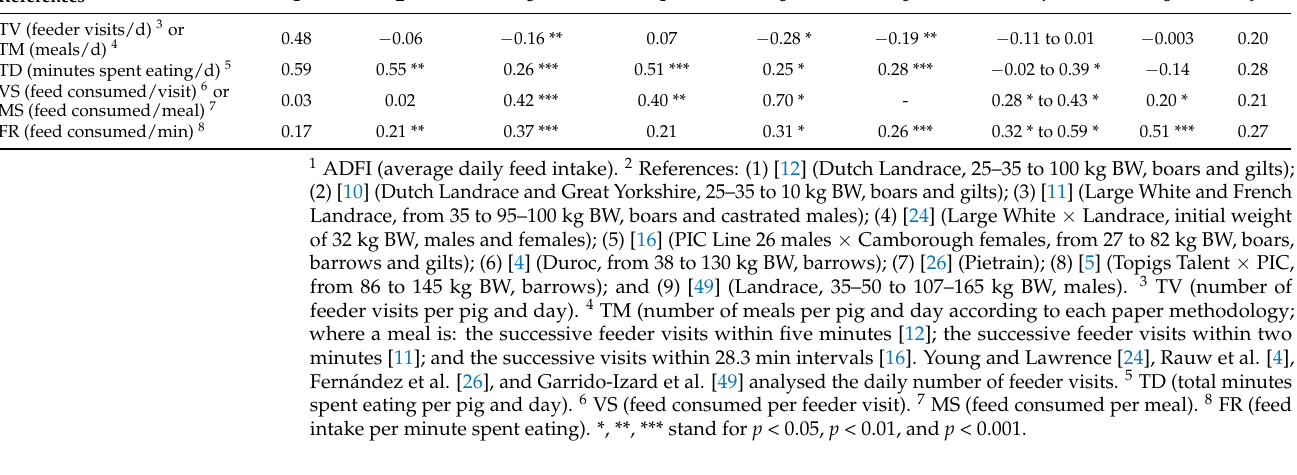
Table 8. Correlation results between the feeding behaviour habits and growth parameters obtained in different